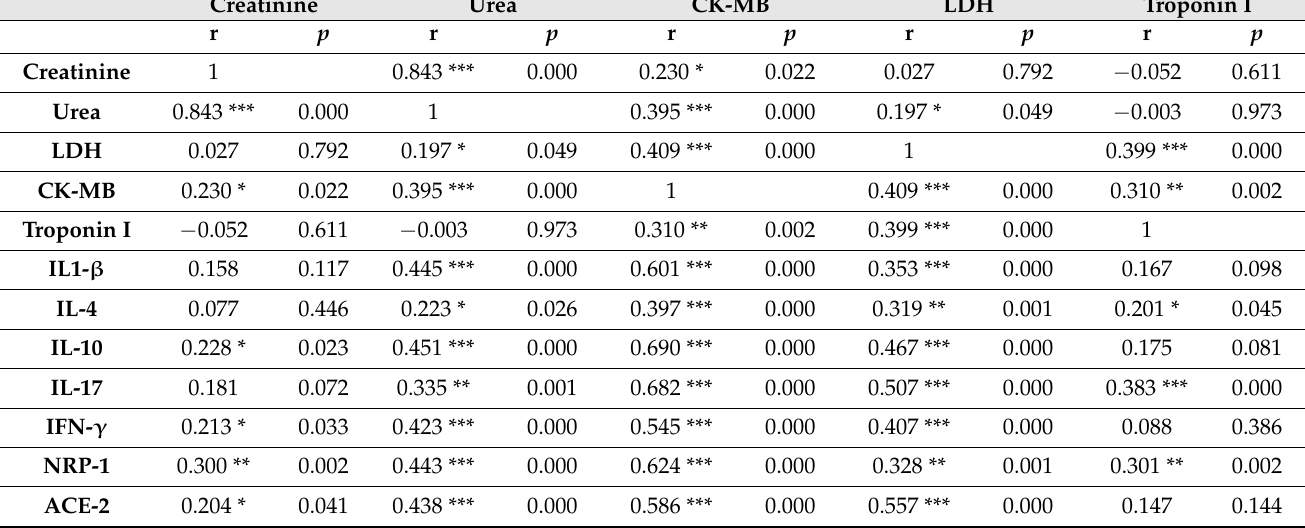
Table 3. Correlations between kidney function biomarkers, cardiac function bioindicators and cytokine levels and ACE-2 and NRP-1 expression levels in the severe